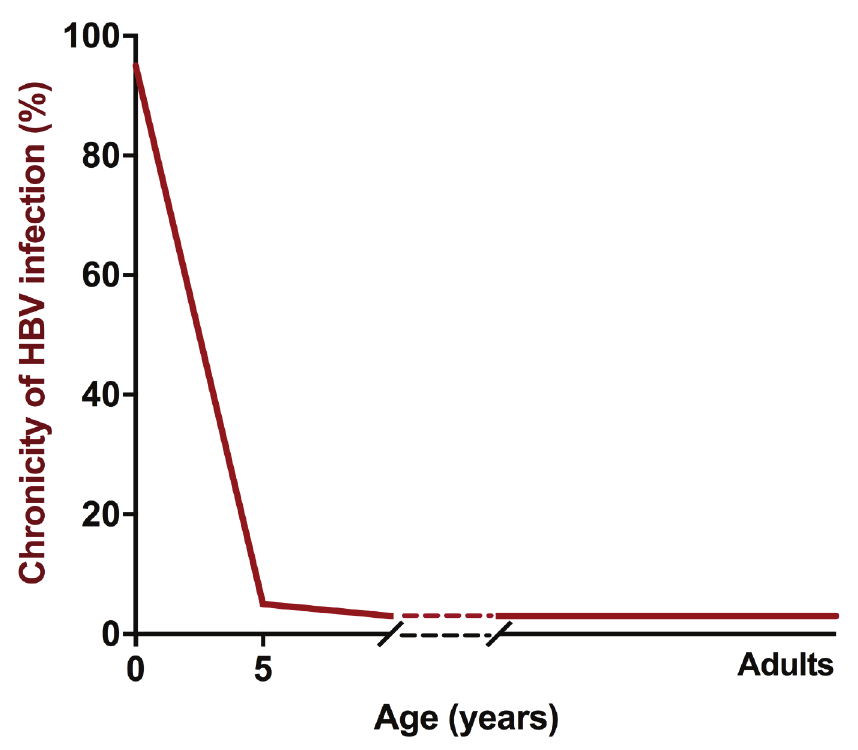
Figure 2: Risk of chronic Hepatitis B related to age. The risk of developing chronic HBV infection is strikingly age